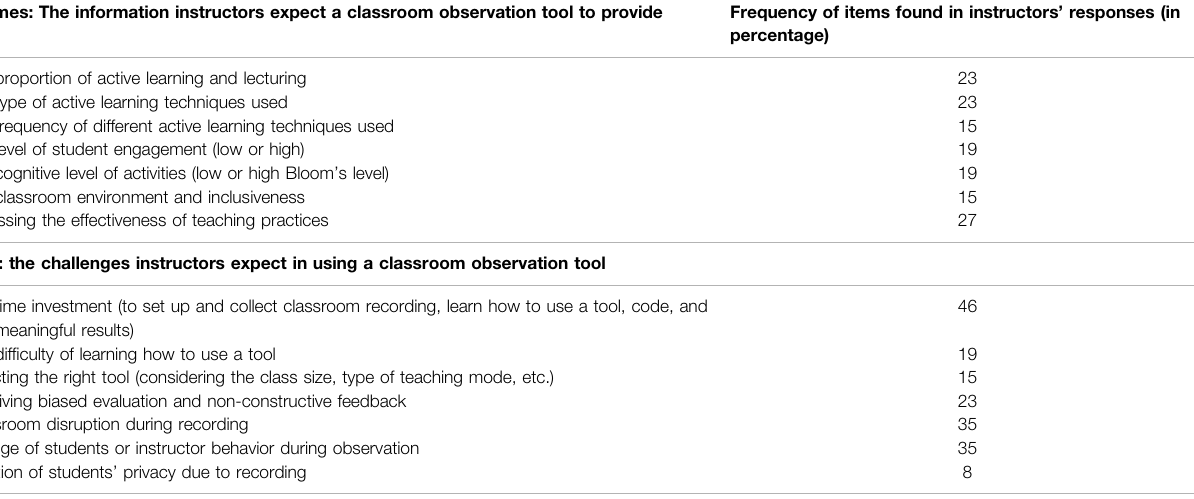
TABLE 2 | A list of possible outcomes and efforts when using a classroom observation tool, generated from responses of a group of STEM instructors